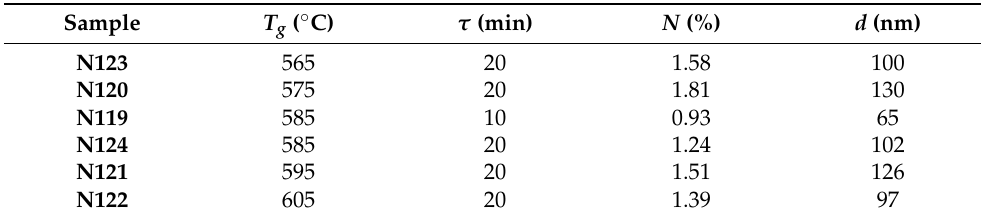
Table 2. The growth temperature T g , deposition time τ , nitrogen content N and thickness d of GaAsN epilayers included in six investigated